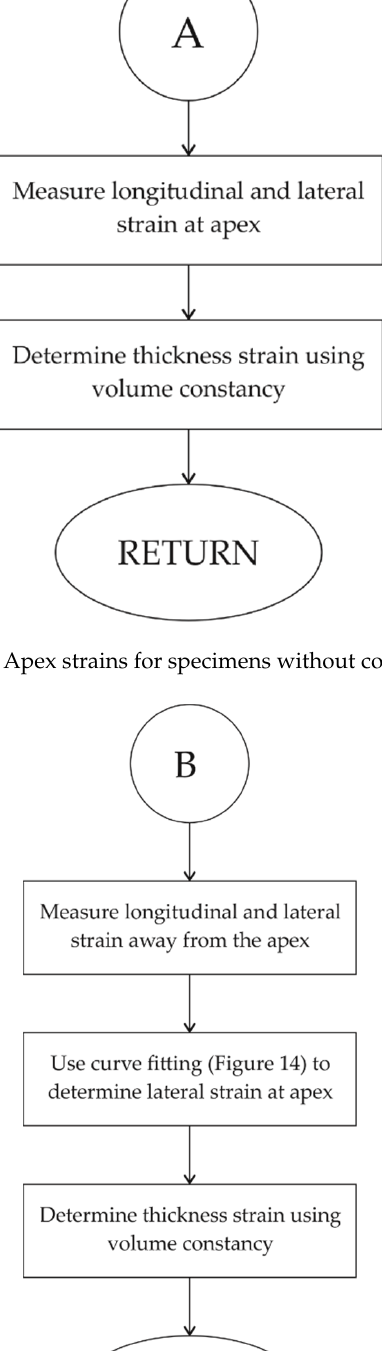
Figure A1. The procedure to determine the EM-FLCs. The flow continues via element D in Figure A4.